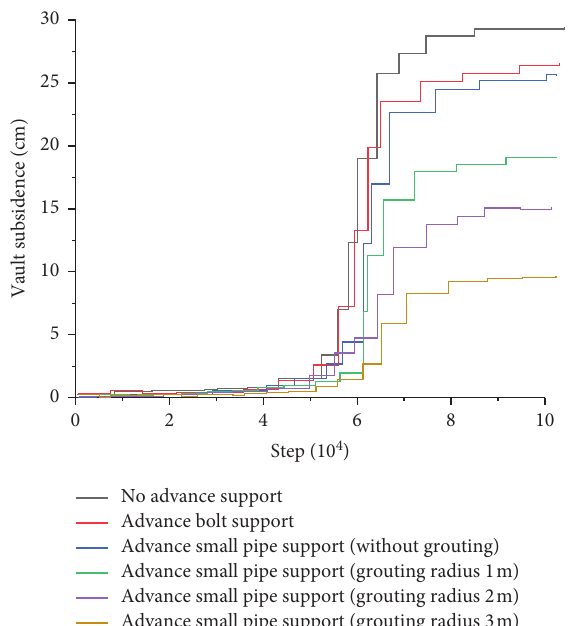
Figure 8: Vault subsidence characteristics under different ad- vanced support schemes.